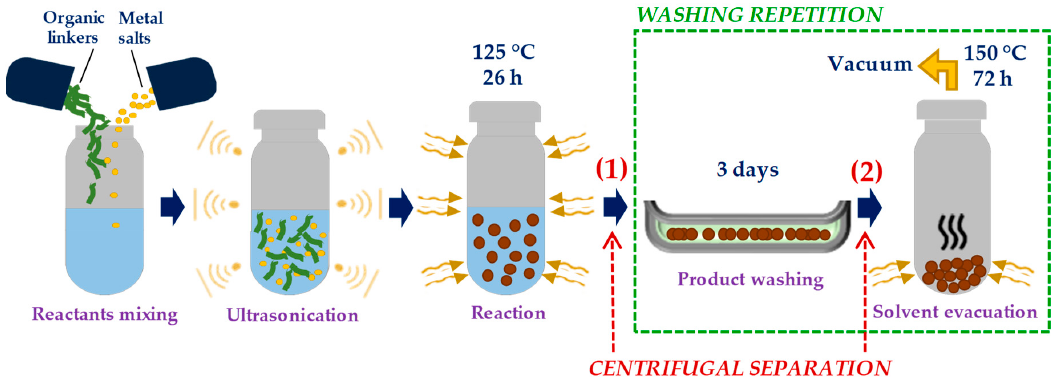
Figure 1. Schematic figure of solvothermal synthesis of this work with repeating washing processes or with additional centrifugal separations. with additional centrifugal